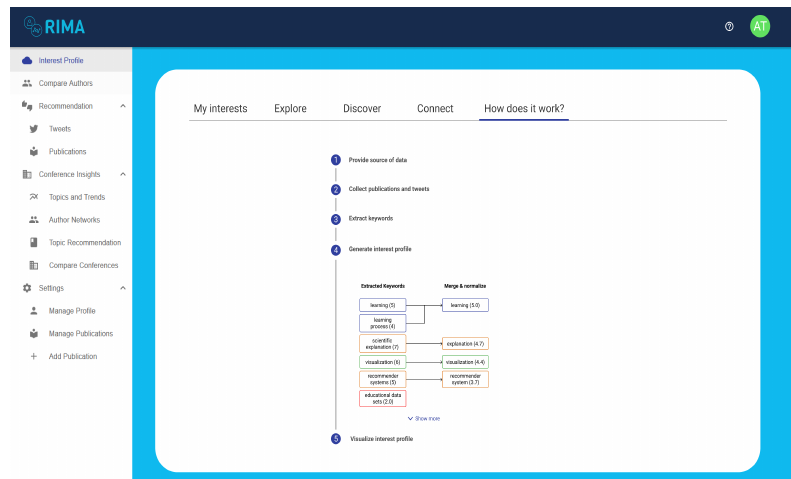
Figure 23. A step by step explanation of the interest model